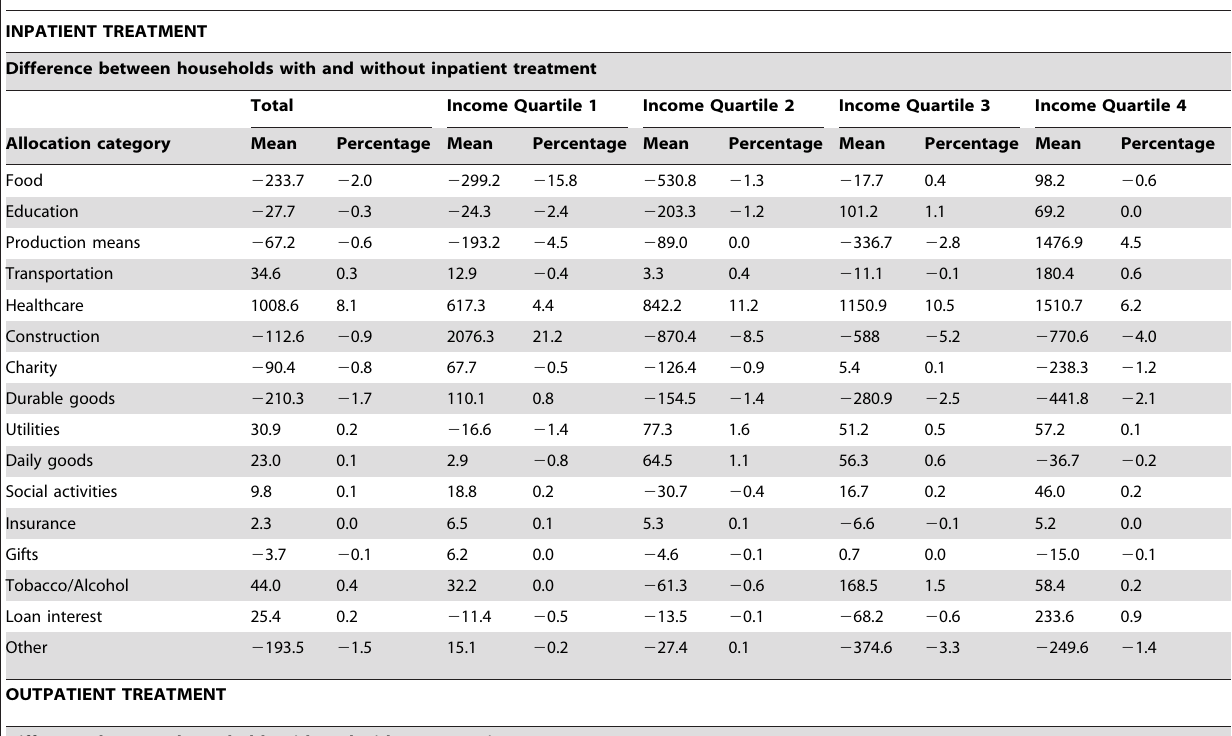
Table 3. Unadjusted differences in allocation categories between households with and without inpatient treatment, and between households with and without outpatient